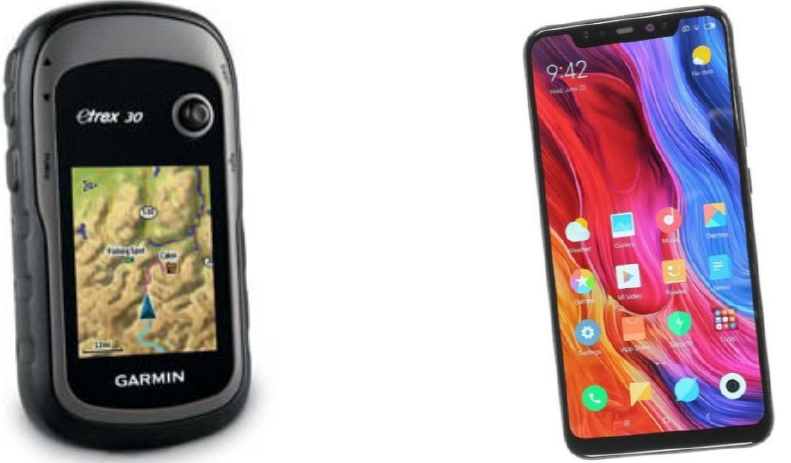
Figure 1. Receivers used in experiments: Garmin Etrex 30 and Xiaomi Mi 8 (Sources: https://www.garmin.com/pl-PL/p/87774/, https://www.gsmarena.com/xiaomi_mi_8-pictures-9065.php: (accessed on 1 April 2022)).